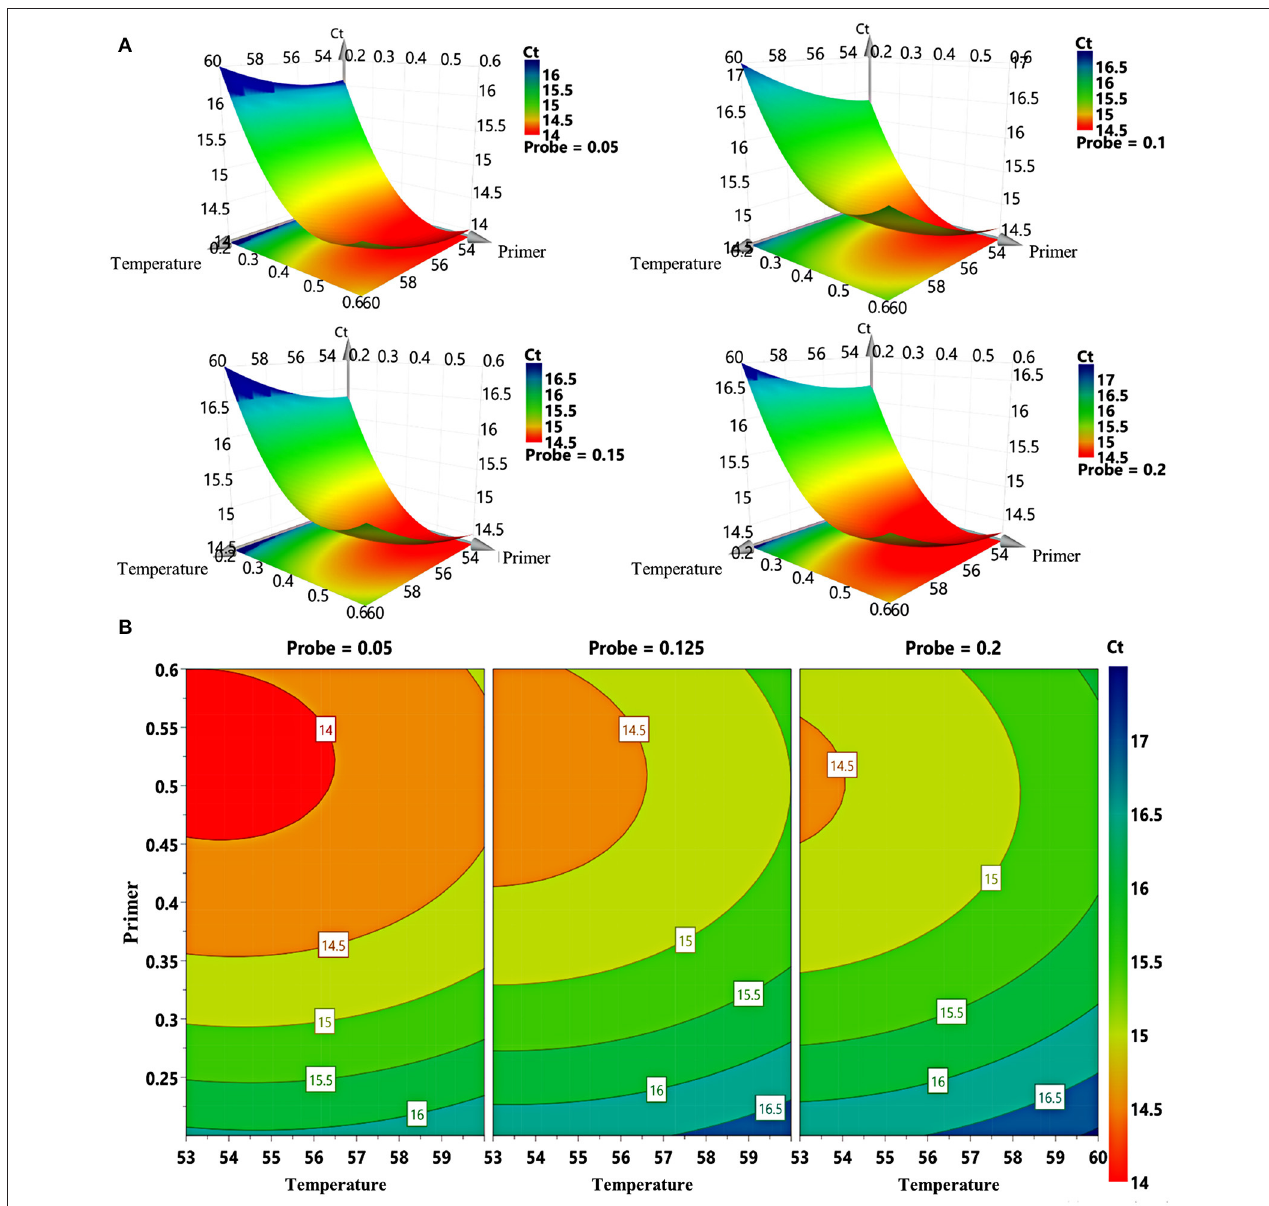
FIGURE 1 | Response surface plots for FCV. (A) 3D response graphs based on different combinations of primer concentration, probe concentration, and annealing temperature generated by computer-aided exchange procedure. (B) Response surface graphs of primer concentration and annealing temperature at different probe